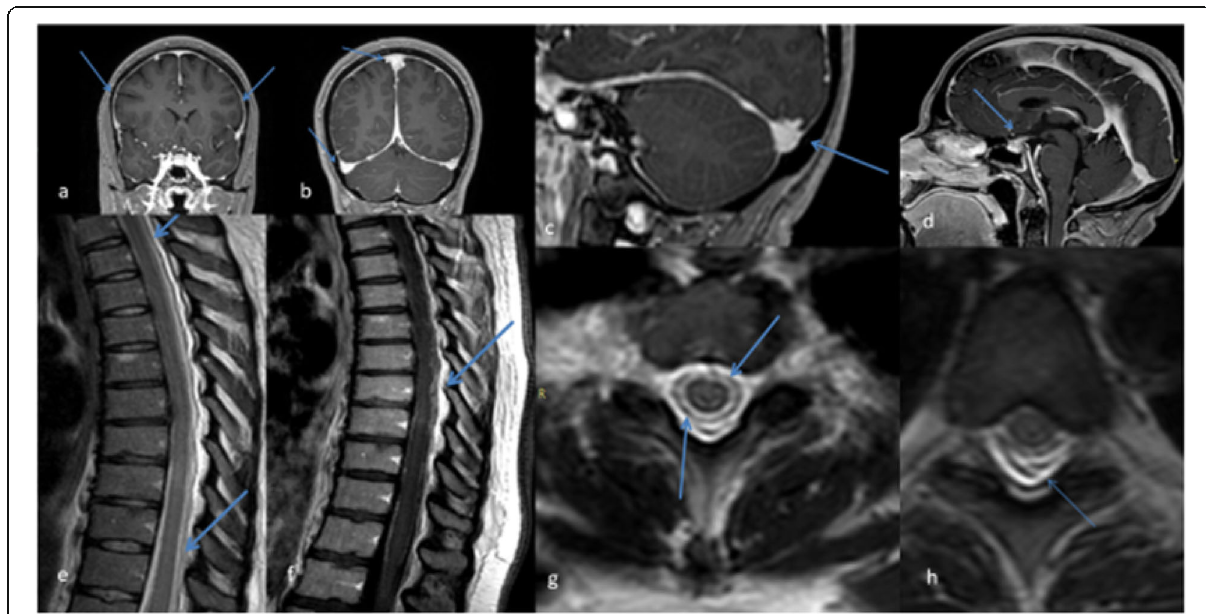
Fig. 1 MRI of the brain and thoracic spine of the patient with spontaneous intracranial hypotenstion. a Coronal contrast-enhanced T1-weighted brain MRI image showing pachymeningeal gadolinium enhancement (blue arrows). b Coronal contrast-enhanced T1-weighted brain MRI image demonstrating distended and rounded dural venous sinuses (blue arrows). c Sagittal contrast-enhanced T1-weighted brain MRI image indicating venous distension sign (rounding of the cross-section of the dural venous sinuses, blue arrow). d Sagittal contrast-enhanced T1-weighted brain MRI image showing mild reduction of suprasellar cistern and enlargement and hyperemia of the pituitary gland (blue arrow). e Sagittal and T2- weighted MRI of the thoracic region showing dorsal fluid collection in the sub/epidural space at the T2 – T10 thoracic vertebra level, causing mild compression of the spinal cord anteriorly (blue arrows). f Midline sagittal contrast-enhanced T1-weighted MRI image of the thoracic region demonstrating marked enhancement of thickened pachyleptomeninges and dilated epidural veins especially at the T6 – T8 level (blue arrows). g A hyperintense band or rim around the spinal thecal sac in axial T2-weighted MRI image at the thoracic level (blue arrows), suggestive of CSF leak. h Axial T2-weighted MRI image at T5 level, showing the “ floating dural sac sign ” (blue